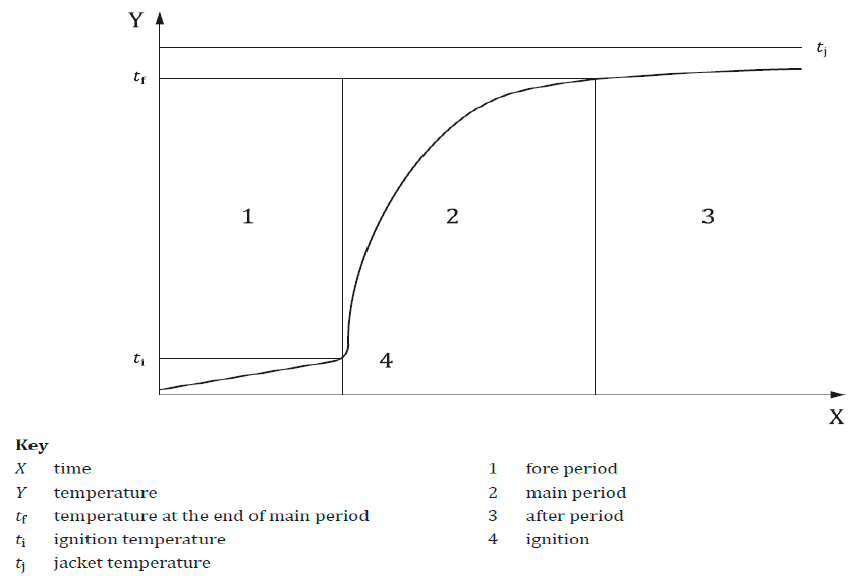
Figure 9. Example time–temperature curve from EN ISO 18125:2017-07 [18].